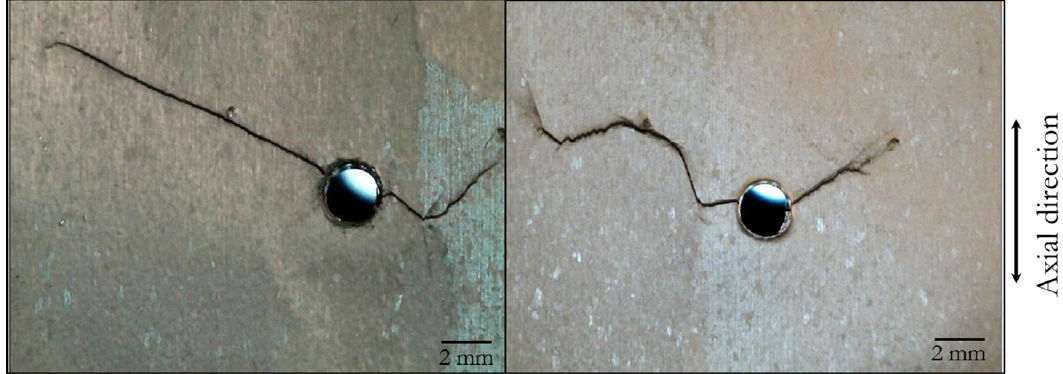
Figure 3: Crack growing from a circular notch with a diameter of 2 mm within a microstructure of 9.74